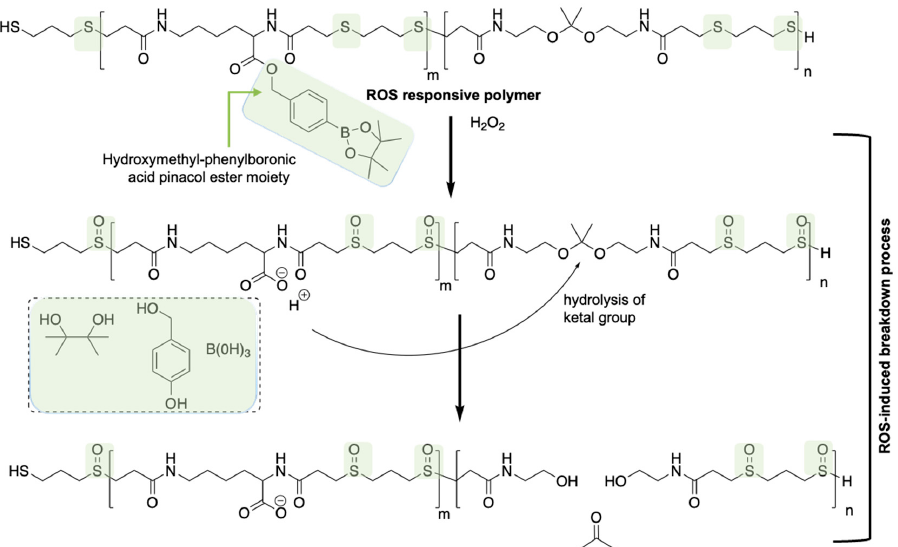
Figure 3. Schematic representation of H 2 O 2 -responsive ROS-ARP degradation mechanism. ROS-responsive moieties are highlighted in green. Recreated from [59].